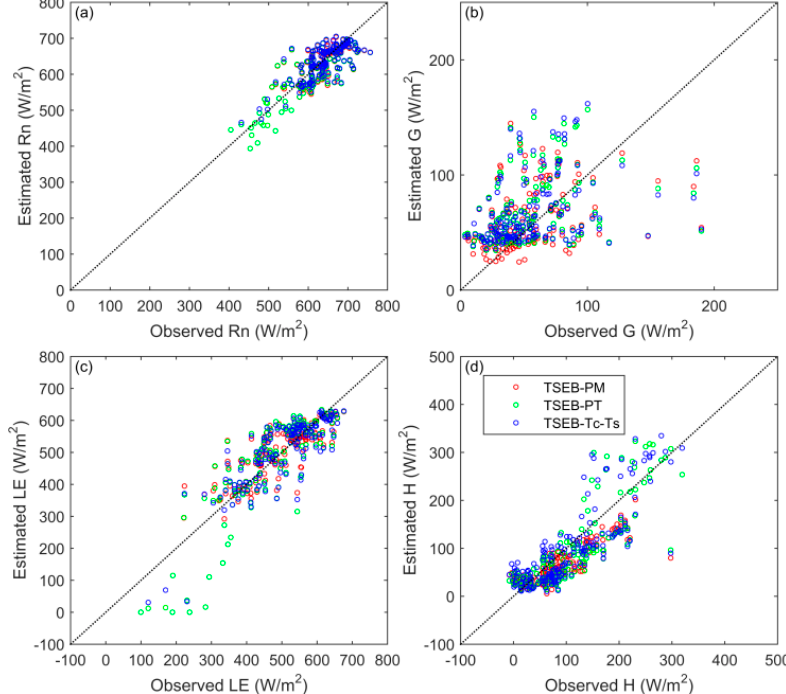
Figure 2. Validation of energy balance components of TSEB-PT, TSEB-PM, and TSEB- T C - T S during the HiWATER experiment at times of ASTER overpass. Energy balance components are ( a ) R n , ( b ) G , ( c ) LE and ( d ) H . Table 1. Validation statistics of TSEB-PM, TSEB-PT and TSEB- T C - T S estimations.